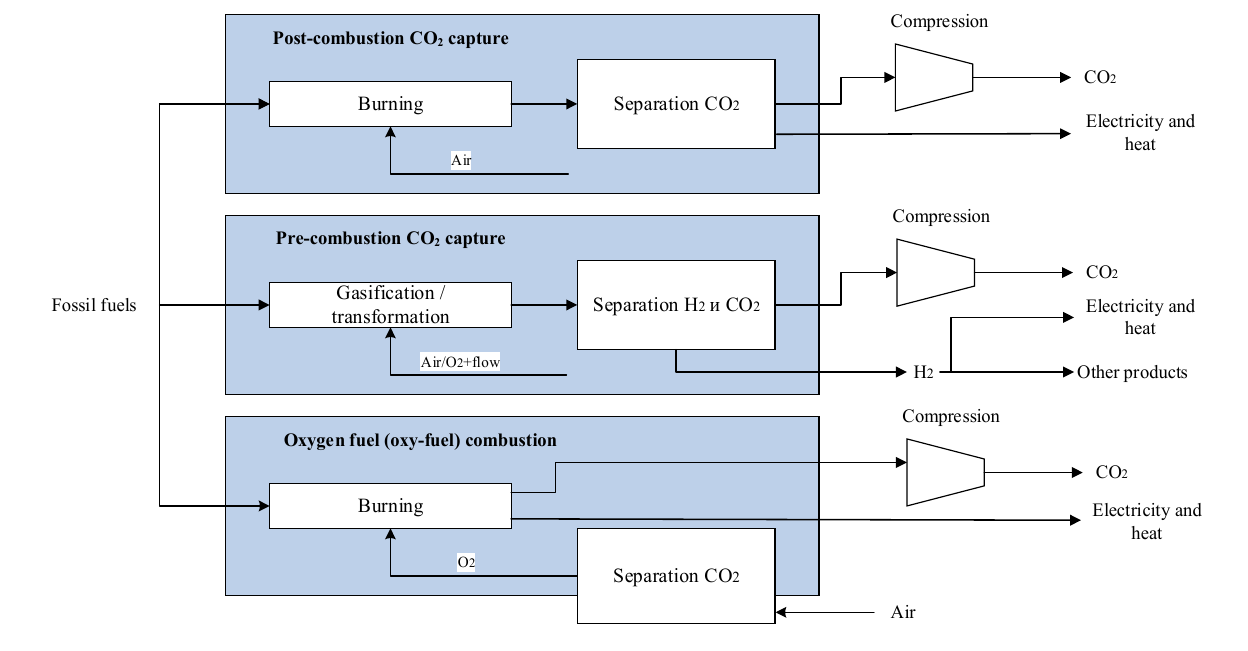
Figure 5. Schematic image of the CO 2 capture systems.